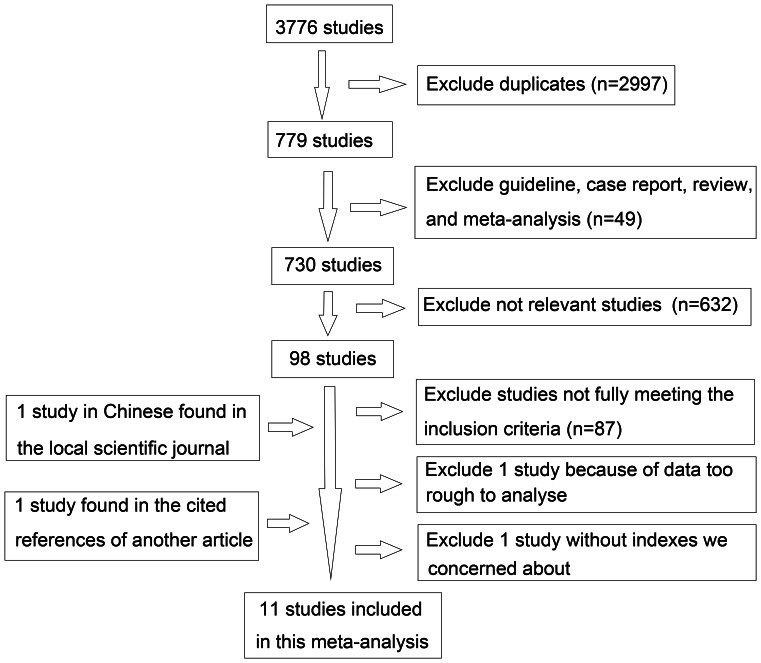
Flow chart of literature search for meta-analysis.